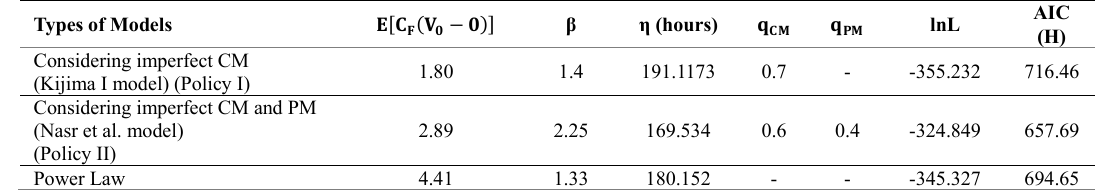
Table 1. Estimated reliability parameters considering different models.